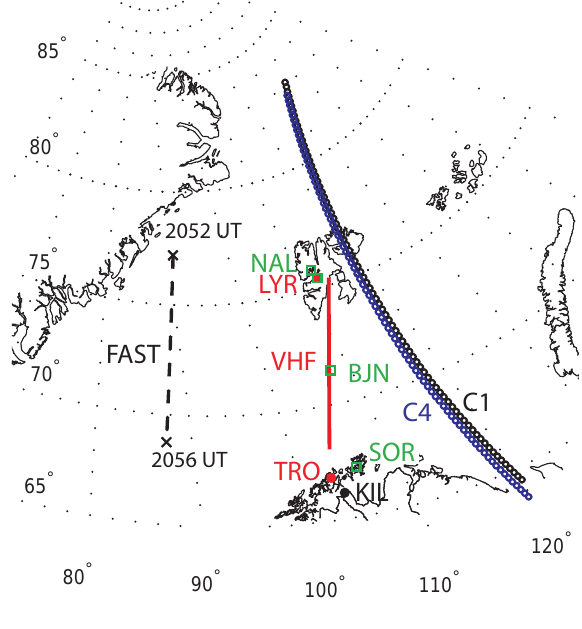
Fig. 1. Cluster orbit for satellites C1 and C4 mapped to the altitude of 100km by using the T89c model with K p =3. The coordinate system is cgm. The footpoints of C2 and C3 are located between those of C1 and C4. The projection of the EISCAT VHF beam and the mapped FAST orbit are also shown. The sites of the VHF radar (TRO), the ESR radar (LYR) and Kilpisj¨arvi all-sky camera (KIL) are indicated by dots. Squares show the northernmost stations of the MIRACLE magnetometer